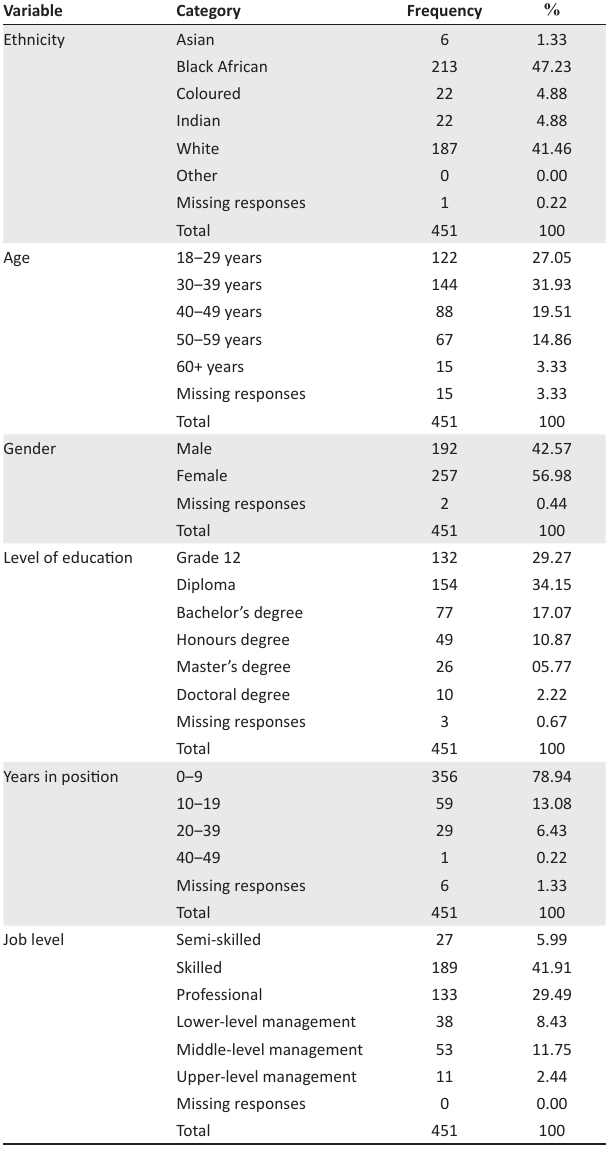
TABLE 1: Respondents’ biographical and demographic information.